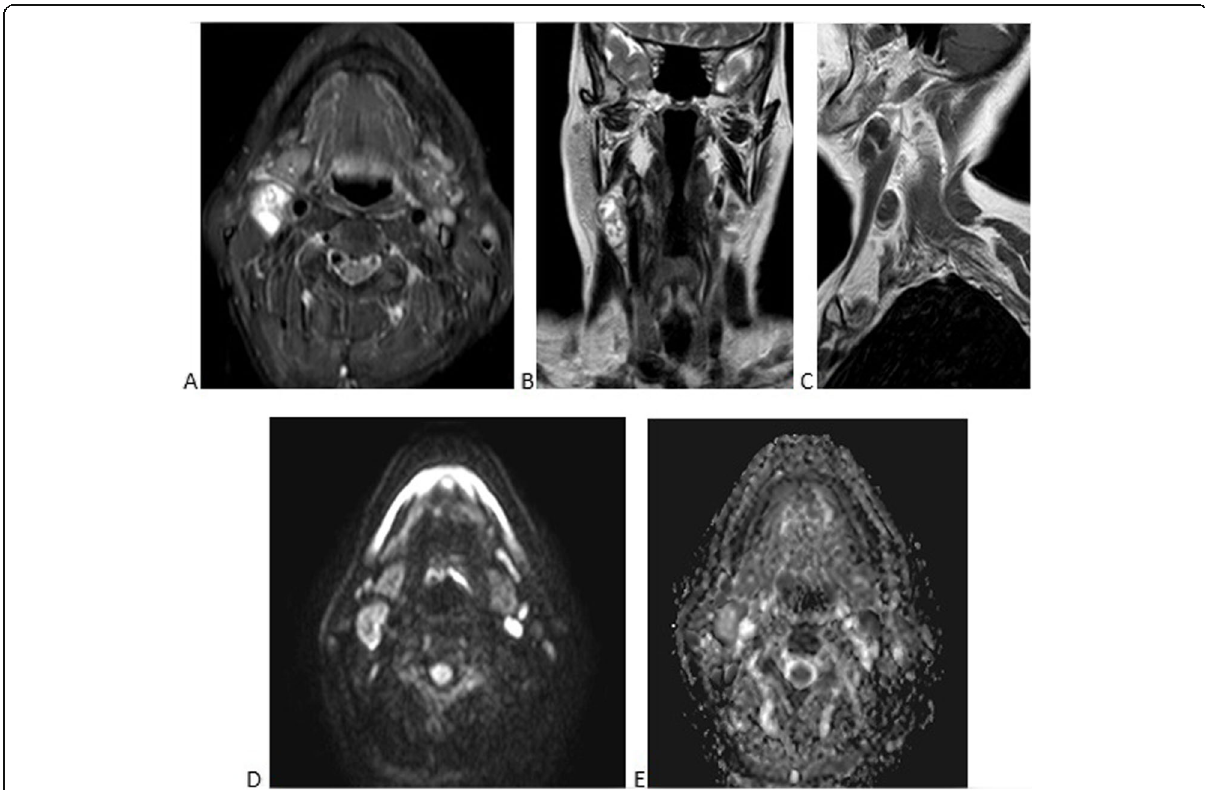
Fig. 8 Sixty- year-old female known case of squamous cell carcinoma of the tongue a axial STIR WIs and b coronal T2 WIs showing few enlarged right cervical lymph nodes with high T2 and STIR signal. c Post-contrast sagittal T1 WIs showing heterogeneous contrast uptake and a large area of breaking down. d DWIs b 1000 and e ADC map showing hyperintense LNs in diffusion WIs and corresponding intermediate to low signal in ADC map ; with an ADC value of 1.127 × 10 − 3 mm 2 /s; the possibility of metastatic nodal deposits is considered which was proven by